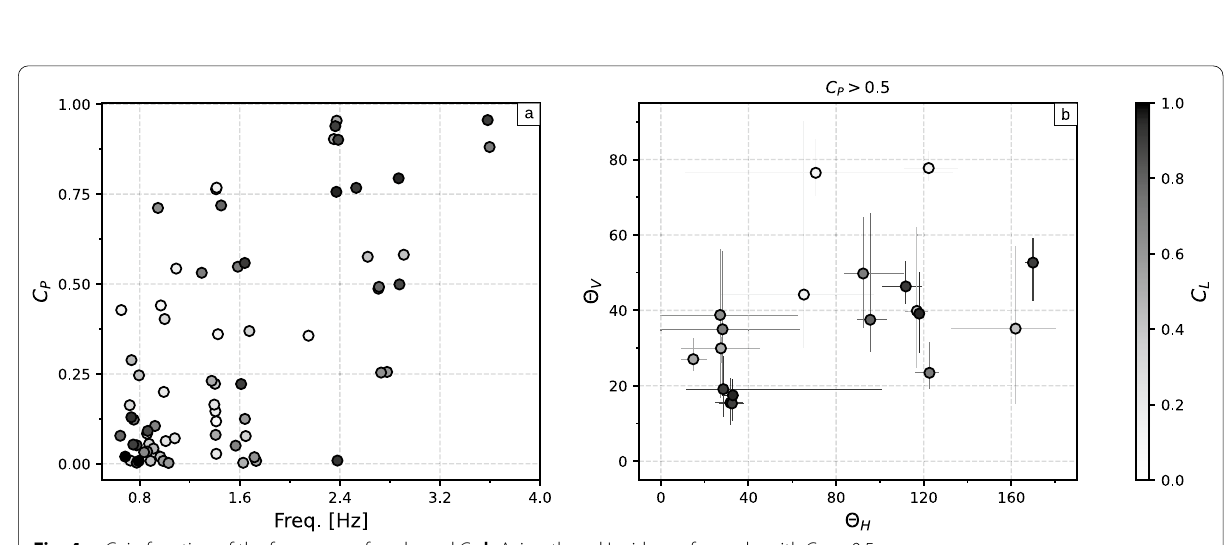
Fig. 4 a C P in function of the frequency of peaks and C L . b Azimuth and Incidence for peaks with C P >